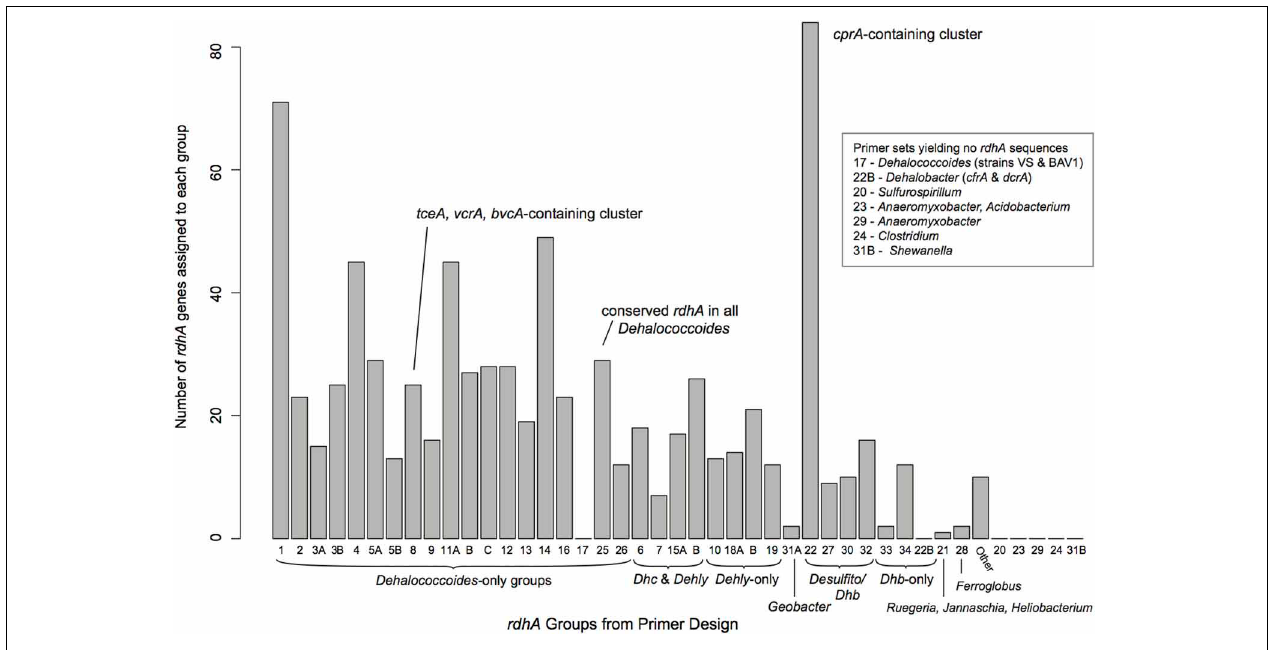
FIGURE 2 | Distribution of identified rdhA genes from the sequenced samples in relation to the RDase primer groups. rdhA genes identified were primarily related to Dehalococcoides, Dehalogenimonas, Dehalobacter ,